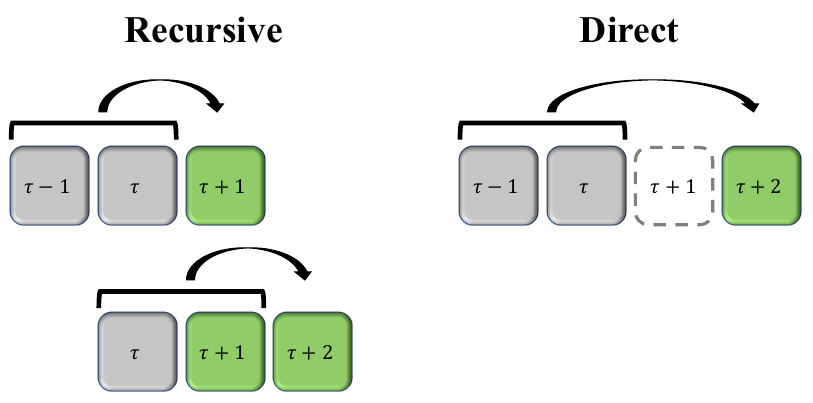
Figure 3. Illustration of the difference between the recursive and direct models for a two-step prediction. Gray blocks represent known data, or data from periods τ − 1 and τ that may be used as inputs. Green blocks represent predictions made by the models. The empty dashed box under direct forecasting represents the time period that is skipped by the two-step direct